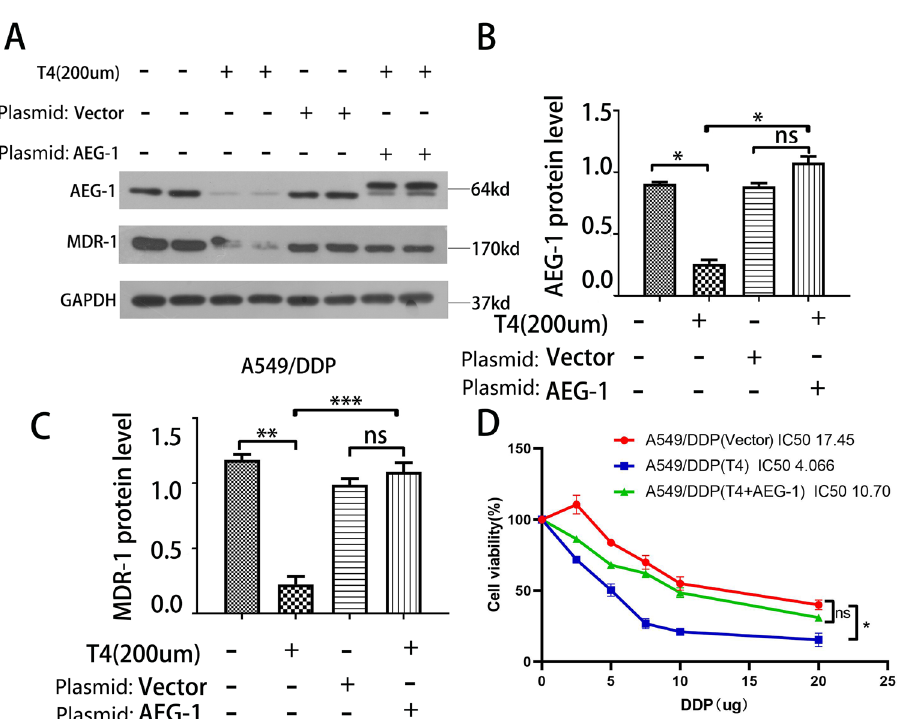
Figure 4. The effect of T4 on the killing effect of cisplatin. ( A – C ) AEG-1 and MDR-1 protein expression in A549/DDP cells; ( D ) The killing effect of cisplatin on A549/DDP